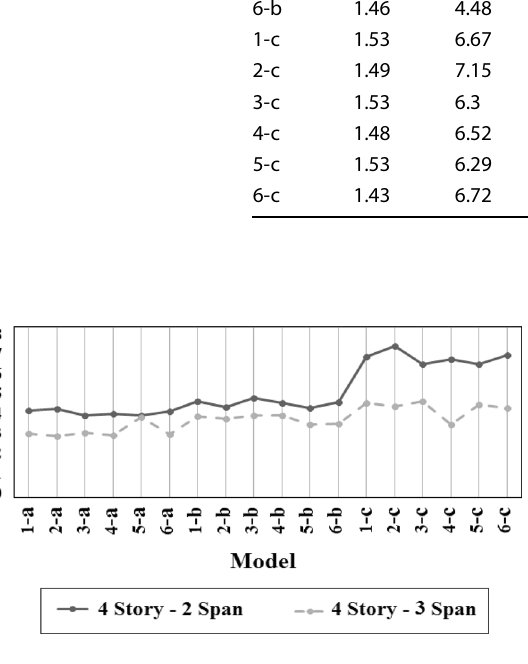
Fig. 11 The ductility coefficient of 4-story 2-span and 3-span struc- ture